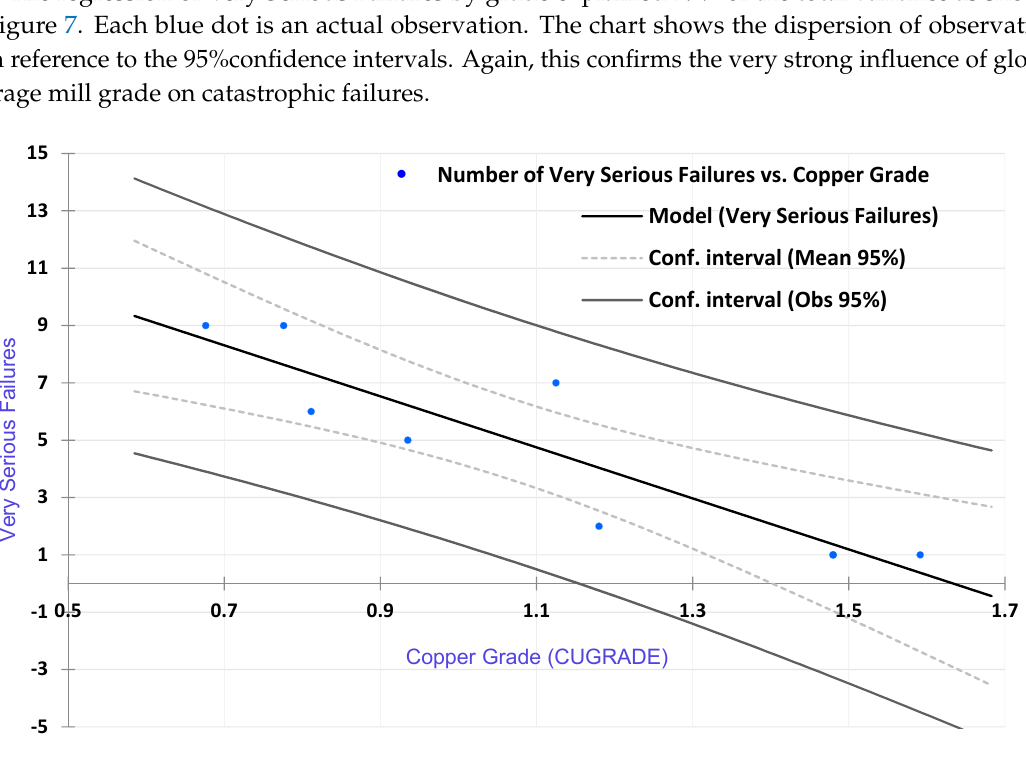
Figure 7. Regression of Very Serious Failures by CUGRADE (R 2 = 0.793).